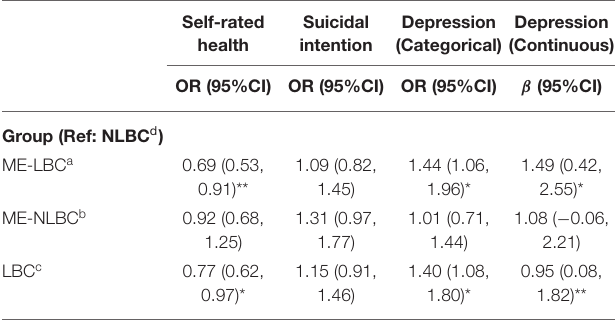
TABLE 4 | Regression coefficients for health outcomes and groups with adjustments for social-demographic